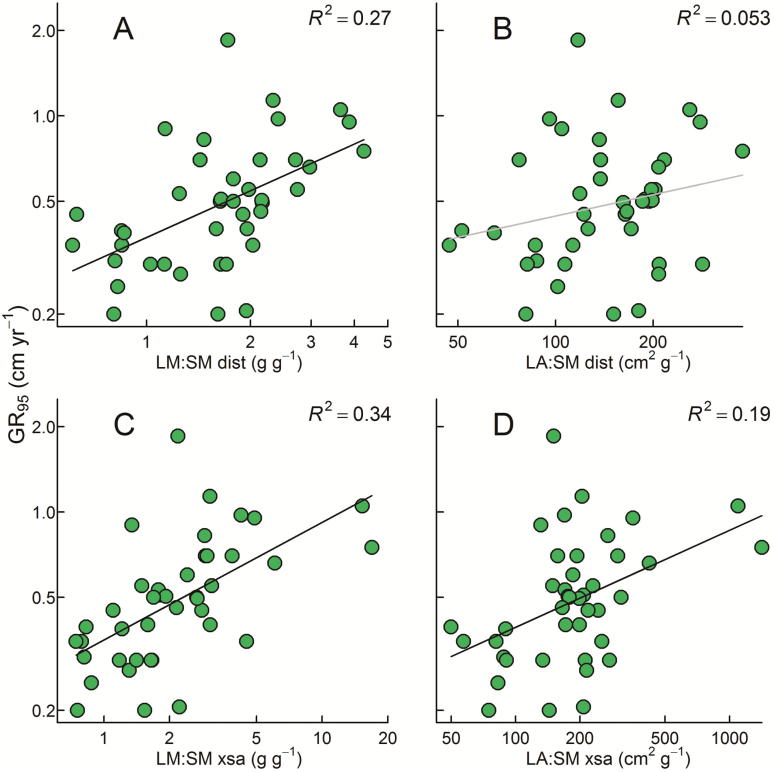
Linear regression relationships between GR95 and leaf:sapwood ratios expressed at a standard distance of 100 cm from the branch tip (A and B) and a standard cross-sectional area (xsa) of 100 mm2 (C and D). Biomass ratios are leaf mass per sapwood mass at (A) 100 mm2 branch cross-sectional area (LM:SM xsa); and (C) a distance of 100 cm from branch tip (LM:SM dist); and leaf area per sapwood mass at (B) 100 cm from branch tip (LA:SM dist); and 100 mm2 branch cross-sectional area (LA:SM xsa). All variables were log10 transformed. Black trend lines indicate significant regression relationships, grey lines show non-significant relationships (P-values reported in Supporting Information—Table S5). Relationships are for 41 tropical rainforest species (species details provided in Supporting Information).